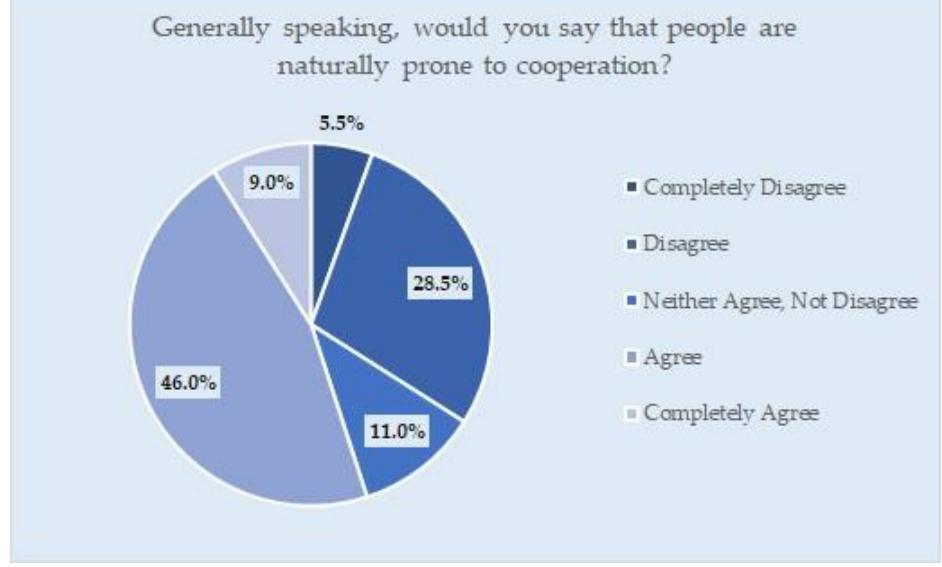
Figure 18. Distribution of responses from the survey.